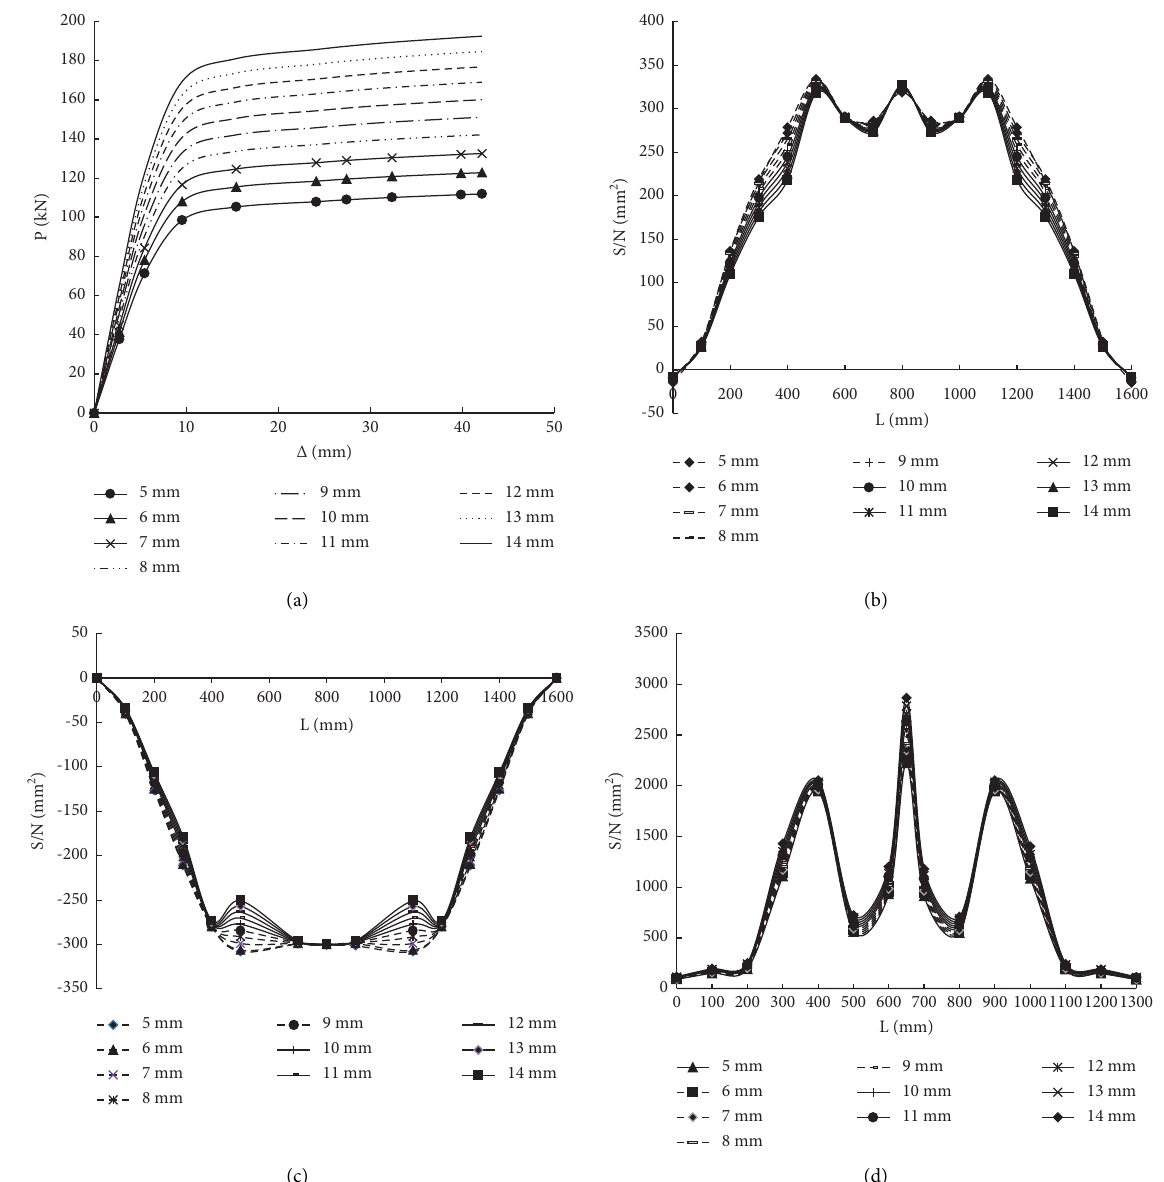
Figure 16: Effect of flange thickness. (a) Load and deflection. (b) Stress along steel beam length. (c) Stress along steel beam width. (d) Stress along CFRP sheet’s